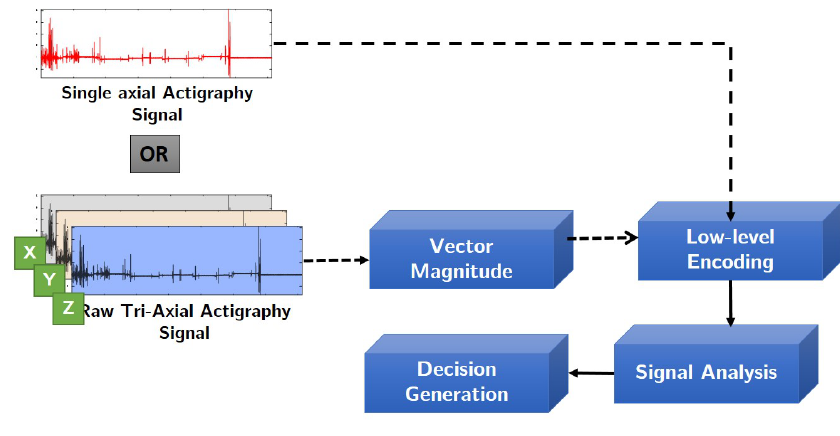
Figure 5. Flowchart of the proposed methodology.